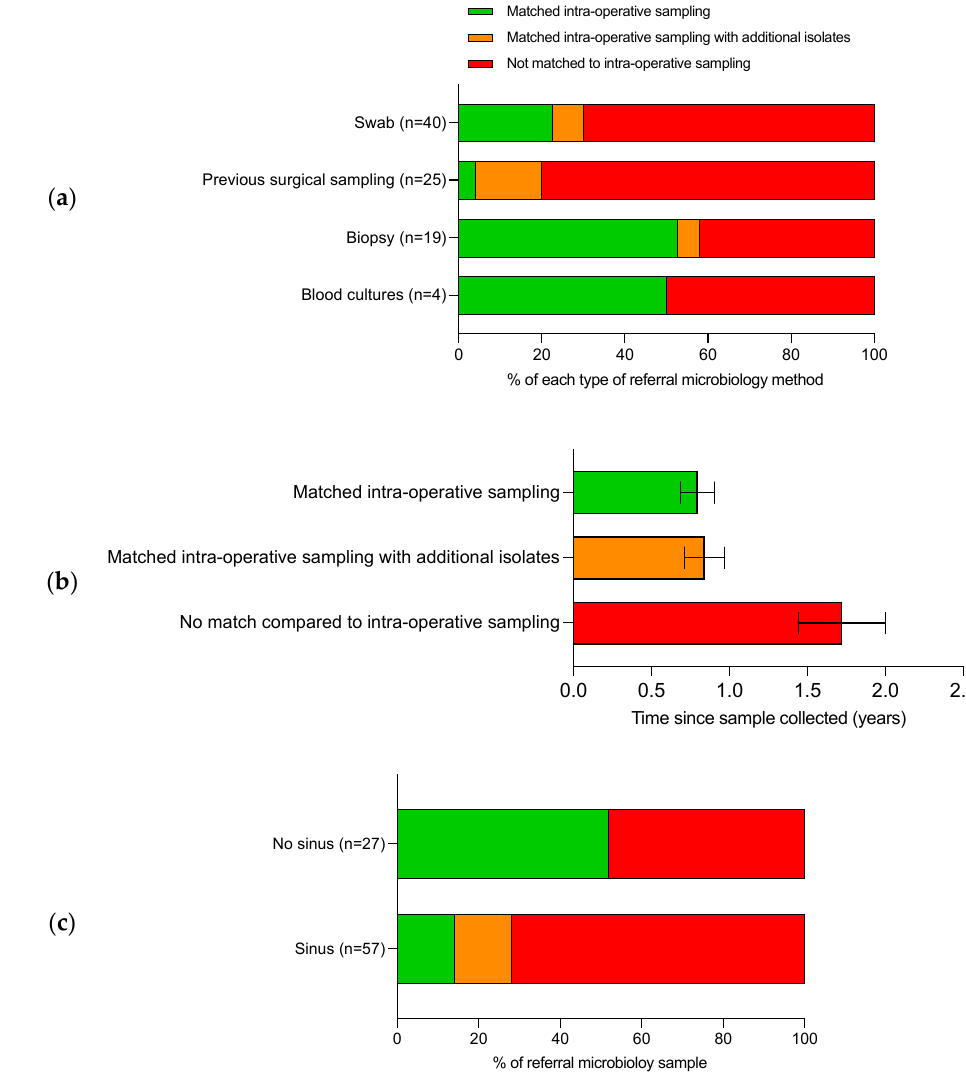
Figure 3. Outcomes of pre-referral microbiology compared to intra-operative sampling. Comparison of pre-referral microbiology to intra-operative sampling by ( a ) method of sampling, ( b ) timing from sampling to operative samples and ( c ) the presence of an active sinus. ‘Complete matches’ are in green, ‘partial matches’ are in orange and ‘non-matches’ are in red.